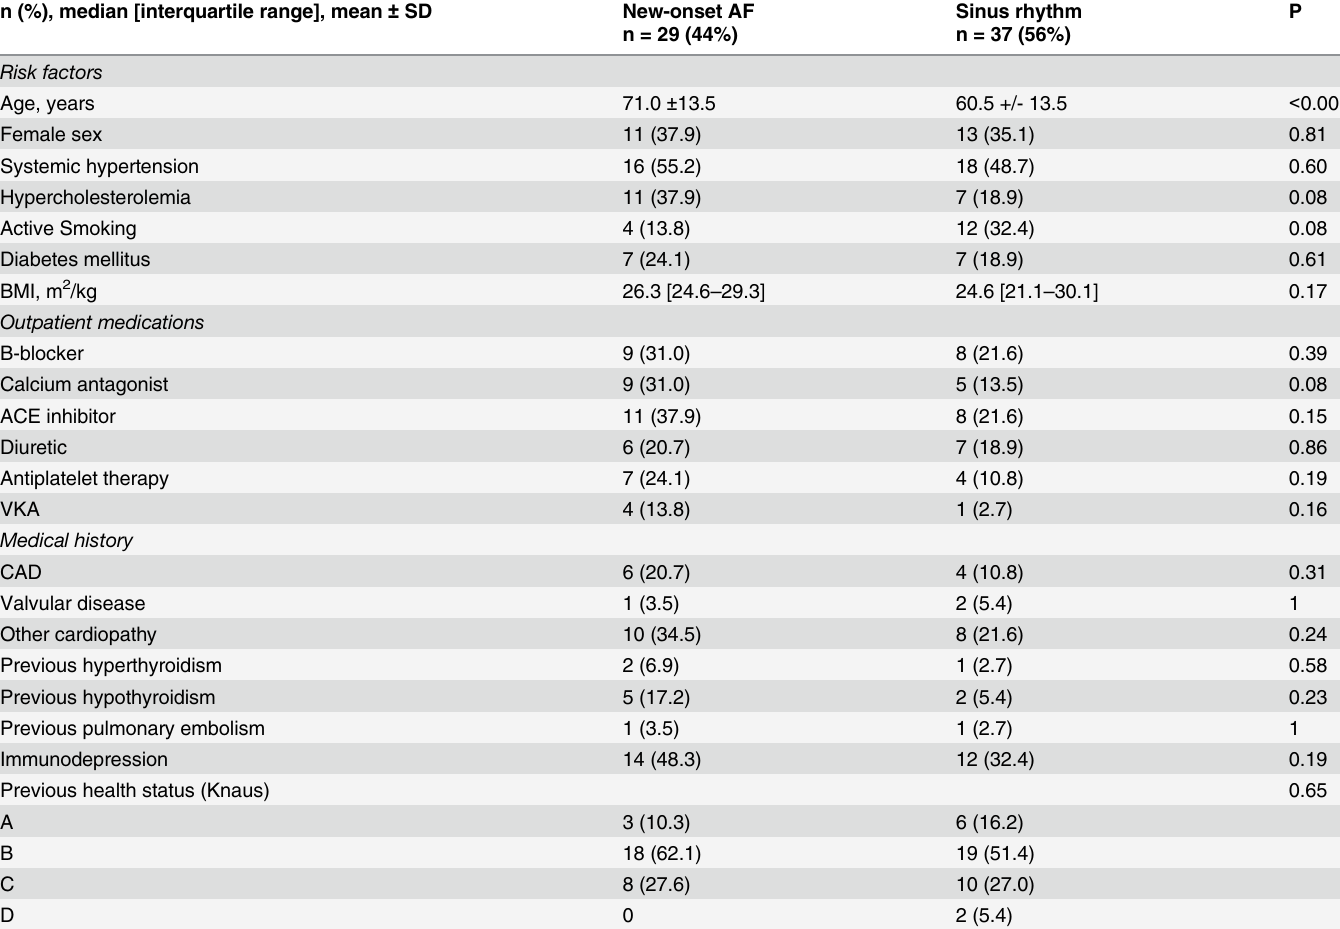
Table 1. Baseline Characteristics According To The Onset Of Atrial Fibrillation.